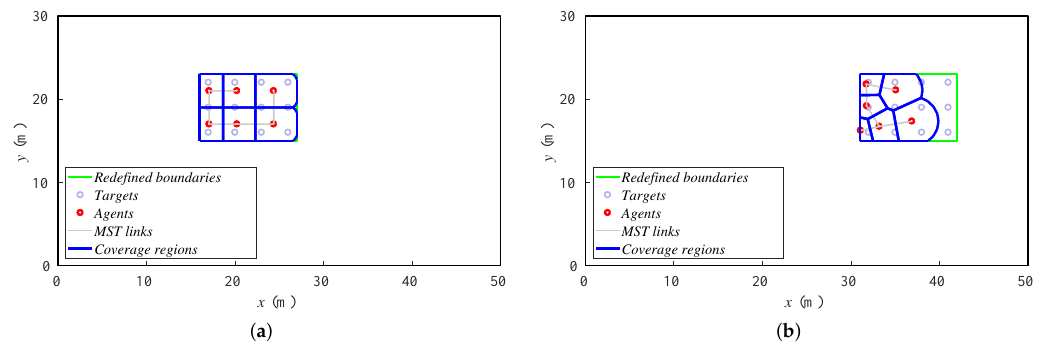
Figure 6. Final positions of agents and targets for ( a ) 0.25 m/step and ( b ) 0.5